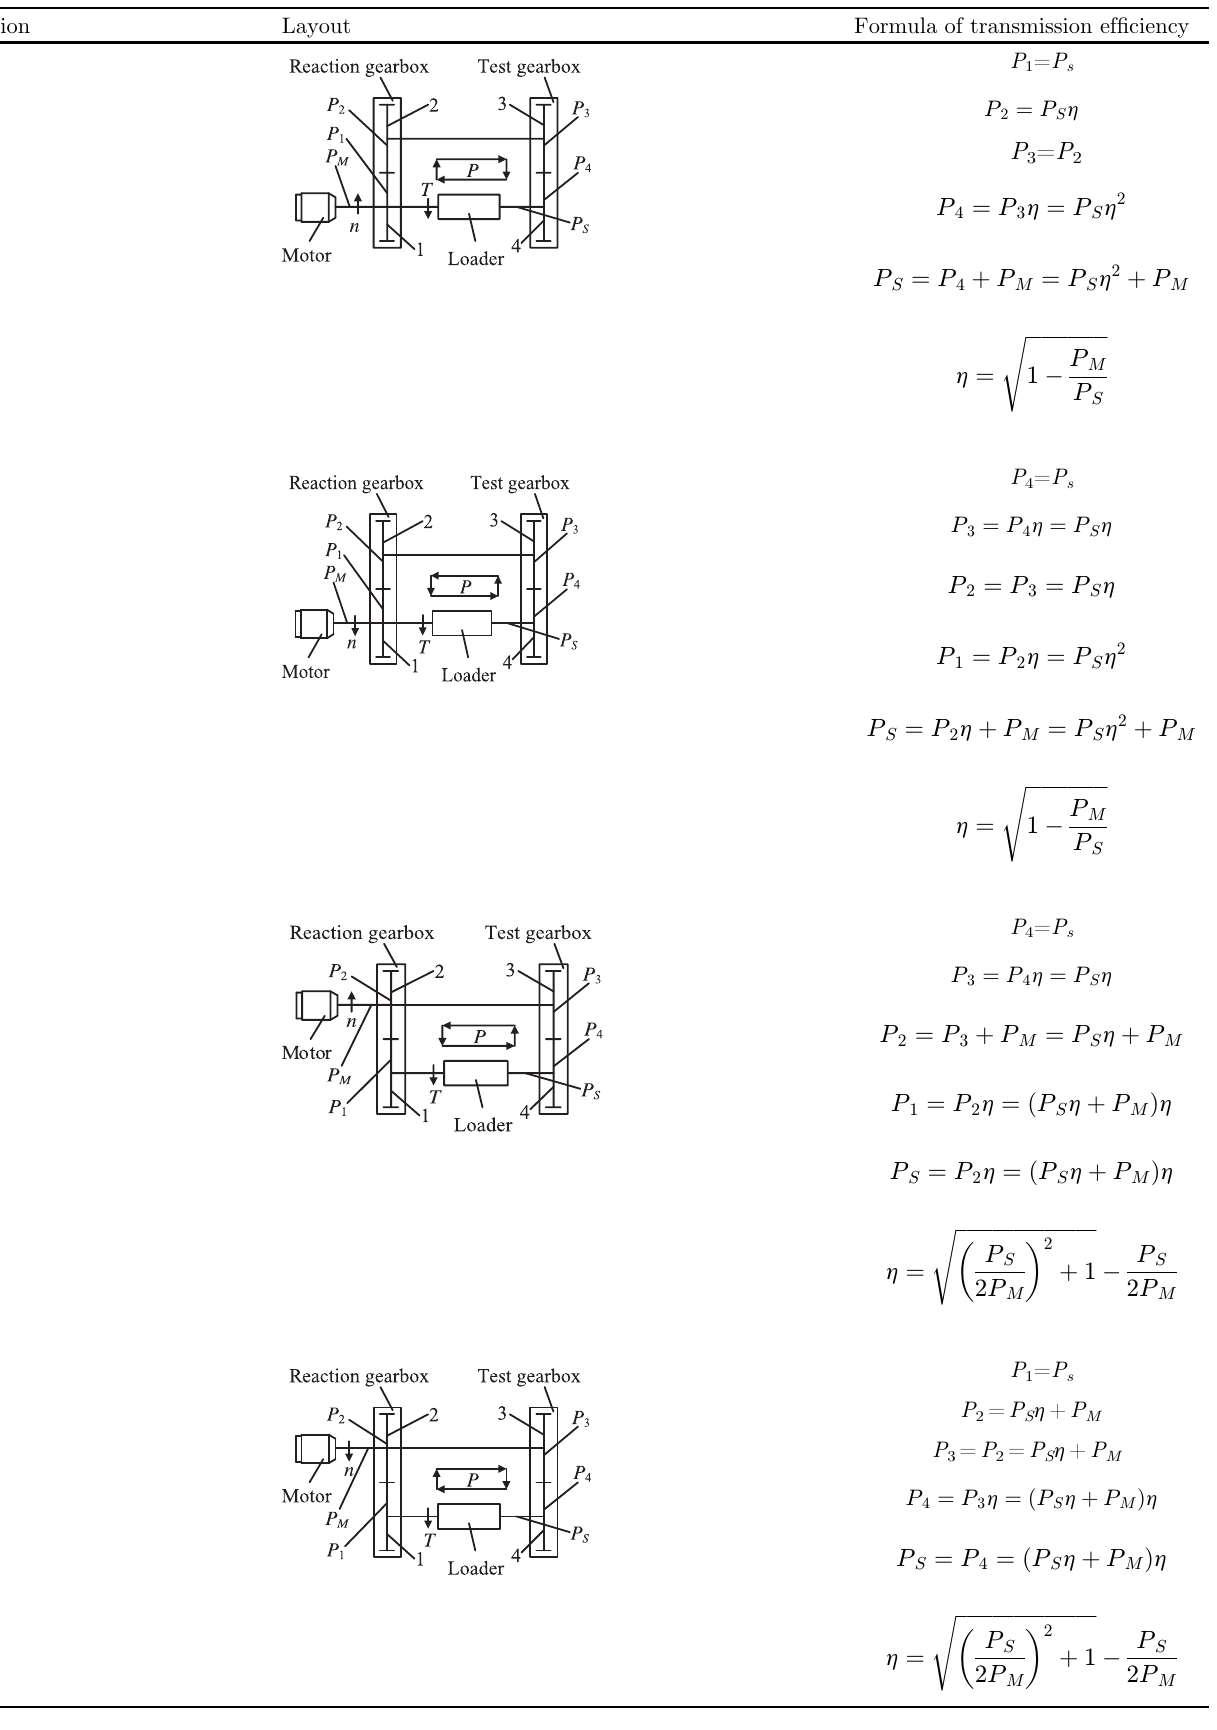
ffiffiffiffiffiffiffiffiffiffiffiffiffiffiffiffi